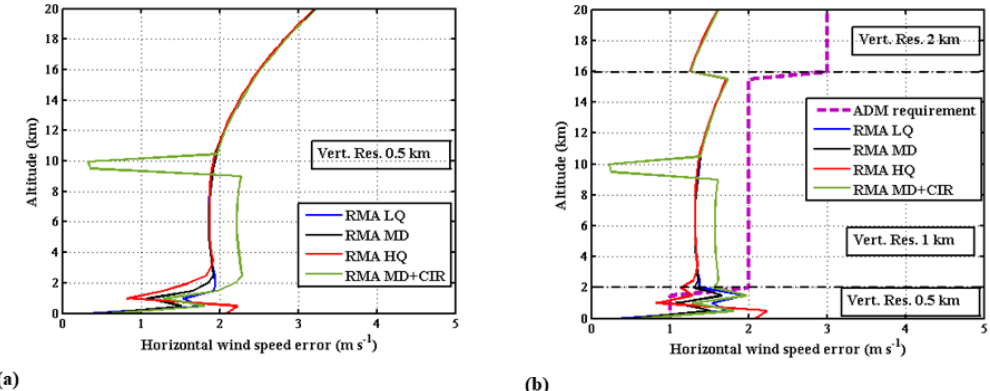
Figure 8. Vertical profile of the horizontal wind speed error (standard deviation) for different backscatter profiles, i.e., LQ, MD, HQ, and MD plus cirrus for the optimal parameters (cid:49) = 3 . 2cm and θ = 45 ◦ . (a) Constant vertical resolution of 0.5km. (b) Variable vertical resolution (0.5 to 2km) and requirements, according to